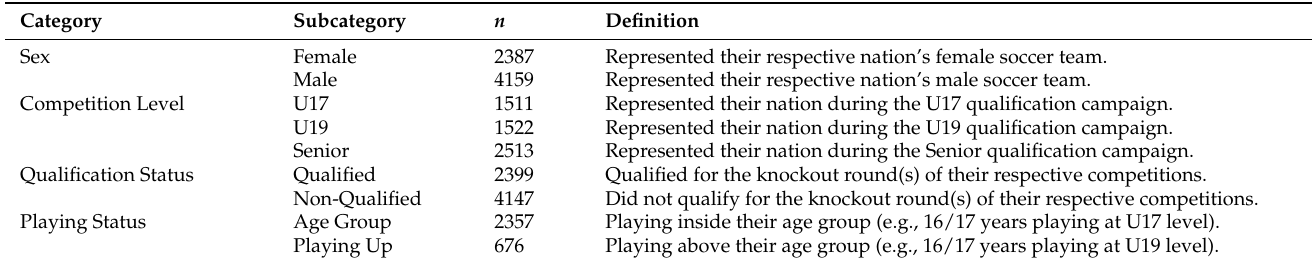
Table 1. Categories, subcategories, and definitions of independent